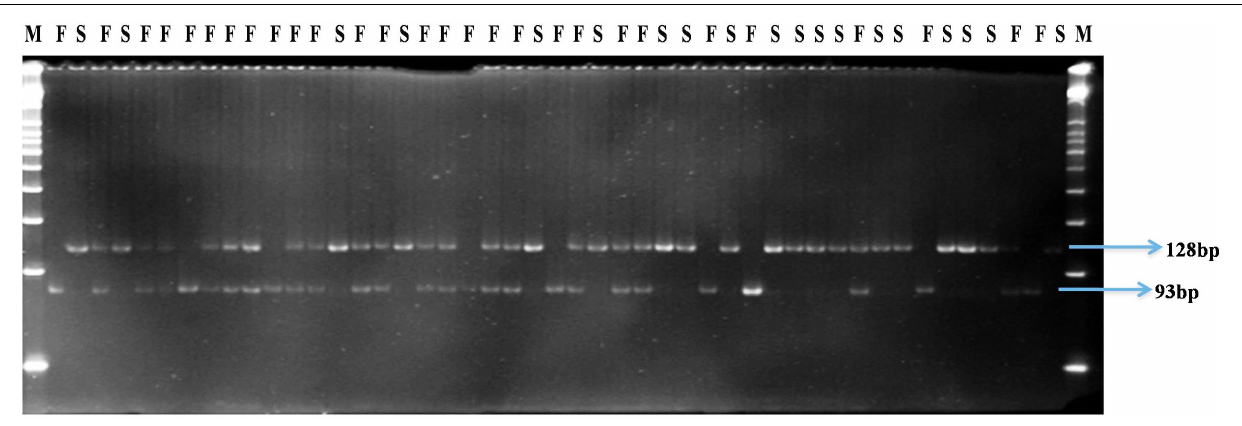
FIGURE 4 | Gel profile of HPGMS3-dCAPS marker linked to ms3 gene in an F 2 segregating population; M, 50 bp DNA ladder; F, male fertile ( Ms3Ms3 / Ms3ms3 ); S, male sterile ( ms3ms3 ).